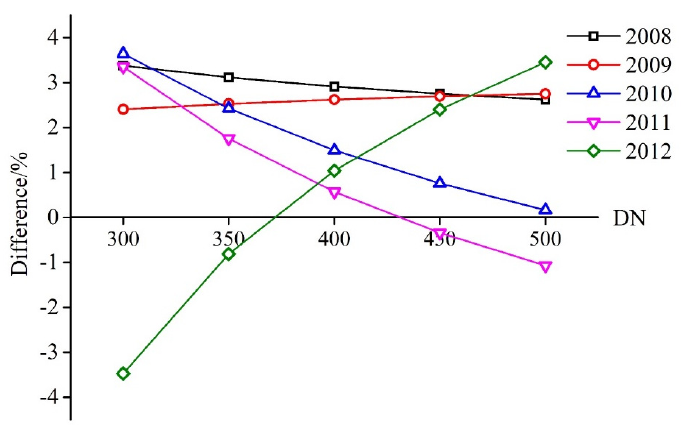
Figure 7. Radiance differences between official coefficients and this study.